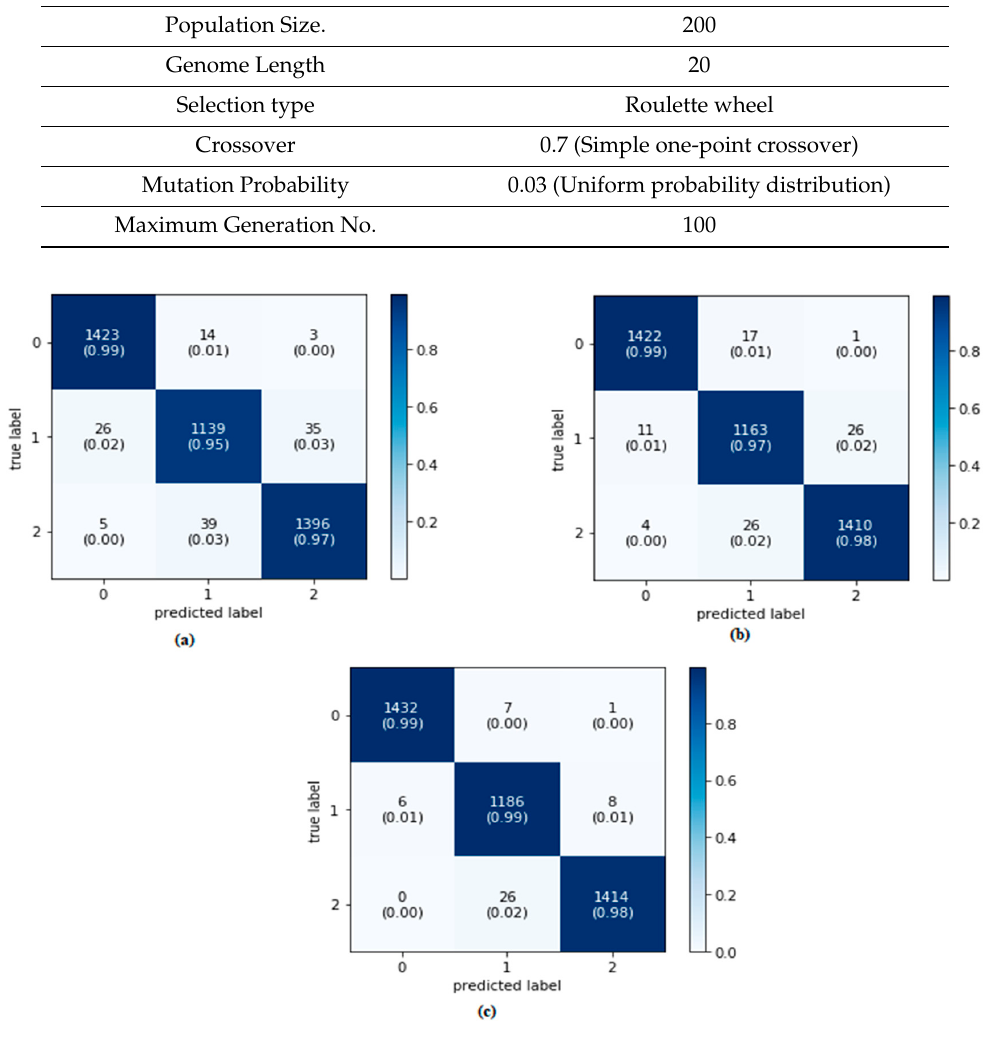
Figure 10. Effect of varying the mutation probability for estimating loss ( a ) and generations for fitness value ( b ). Table 5. The genetic algorithm parameters settings for feature selection. Parameter Name.